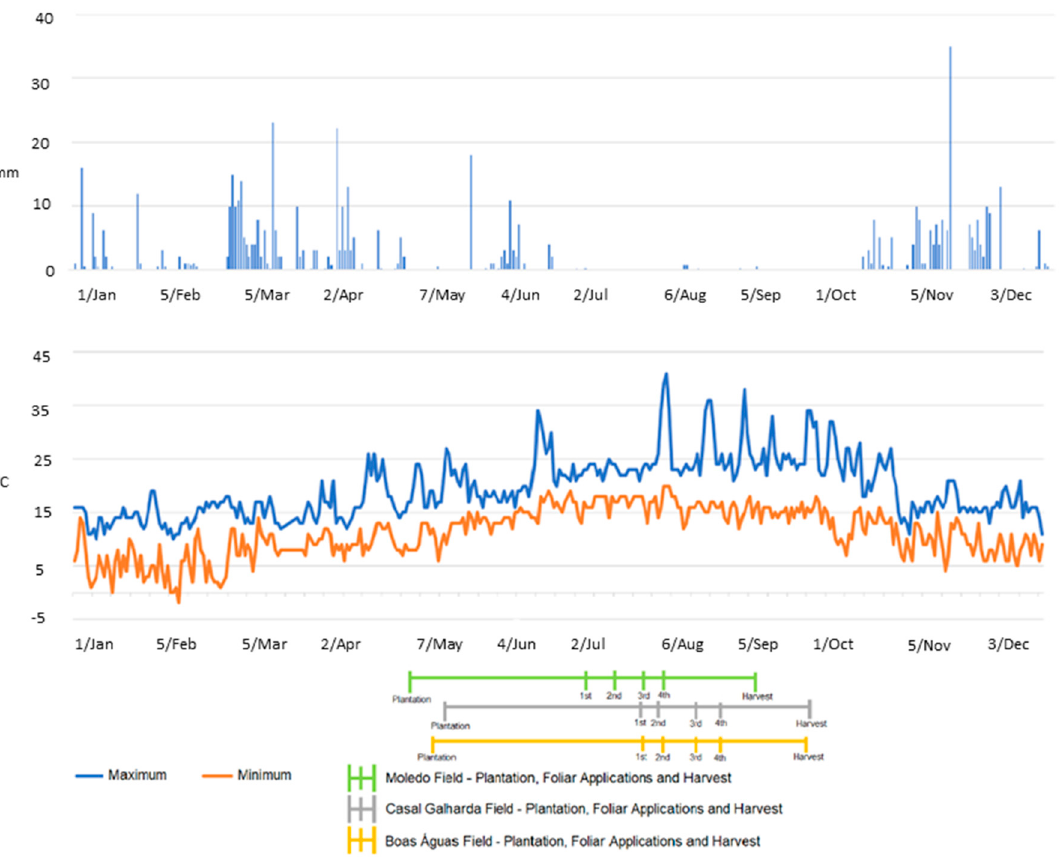
Figure 5. Humidity (mm) and maximum and minimum temperatures (°C). Indication of plantation, foliar applications, and harvest in the S. tuberosum fields (Moledo, Casal Galharda and Boas Águas).